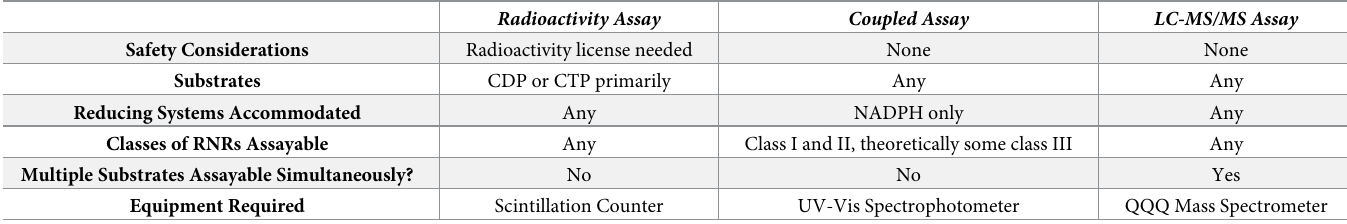
Table 3. Comparison of the radioactivity and coupled RNR activity assays and the LC-MS/MS assay described in this